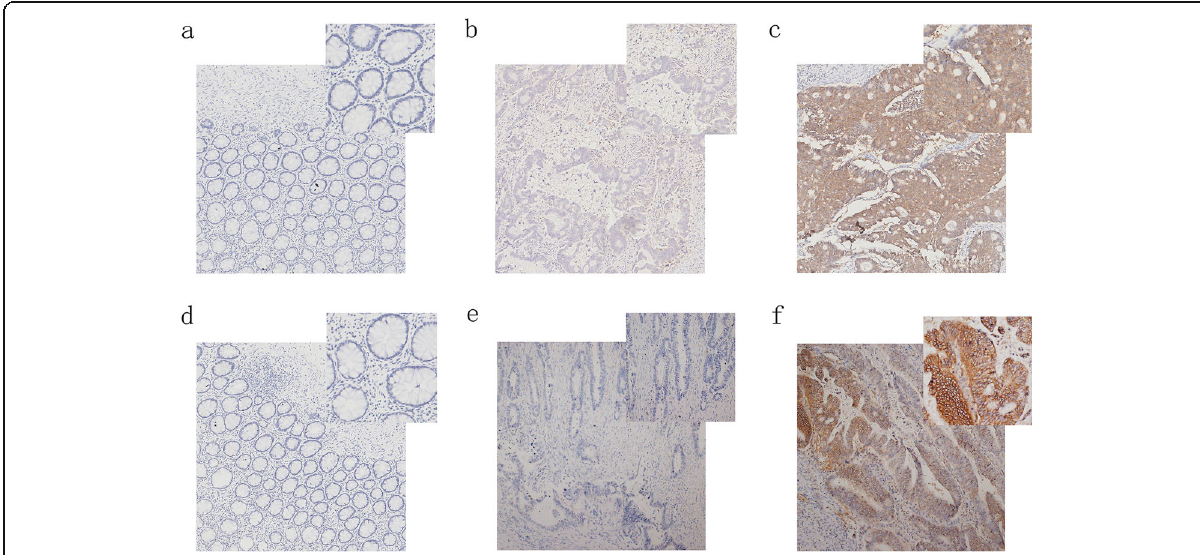
Fig. 1 Immunohistochemistry of PI3K-Akt in colorectal cancer tissues and normal intestinal epithelial tissues a PI3K (p110 α ) is negatively expressed in normal intestinal epithelial tissues. b PI3K (p110 α ) negatively expressed in PIK3CA wild-type CRC tissues. c PI3K (p110 α ) is positively expressed in PIK3CA mutant CRC tissues. d Raptor is negatively expressed in normal intestinal epithelial tissues. e Raptor is negatively expressed in PIK3CA wild-type CRC tissues. f Raptor is positively expressed in PIK3CA mutant CRC